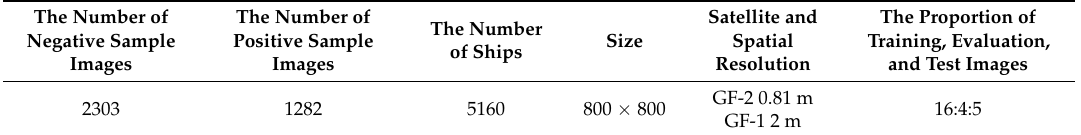
Table 1. Information of small image dataset.